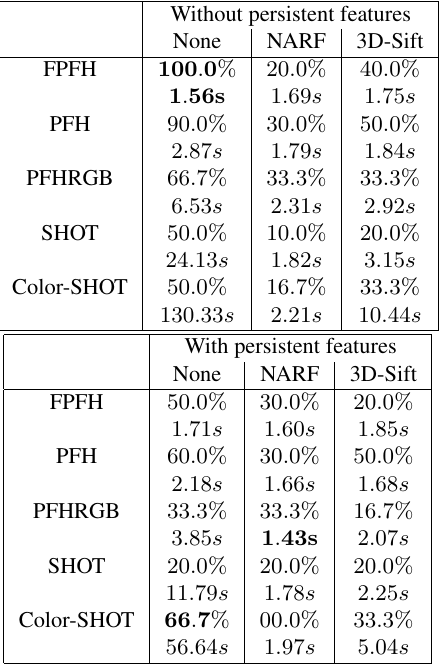
Table 3: Runtime and subjective results (100 ICP